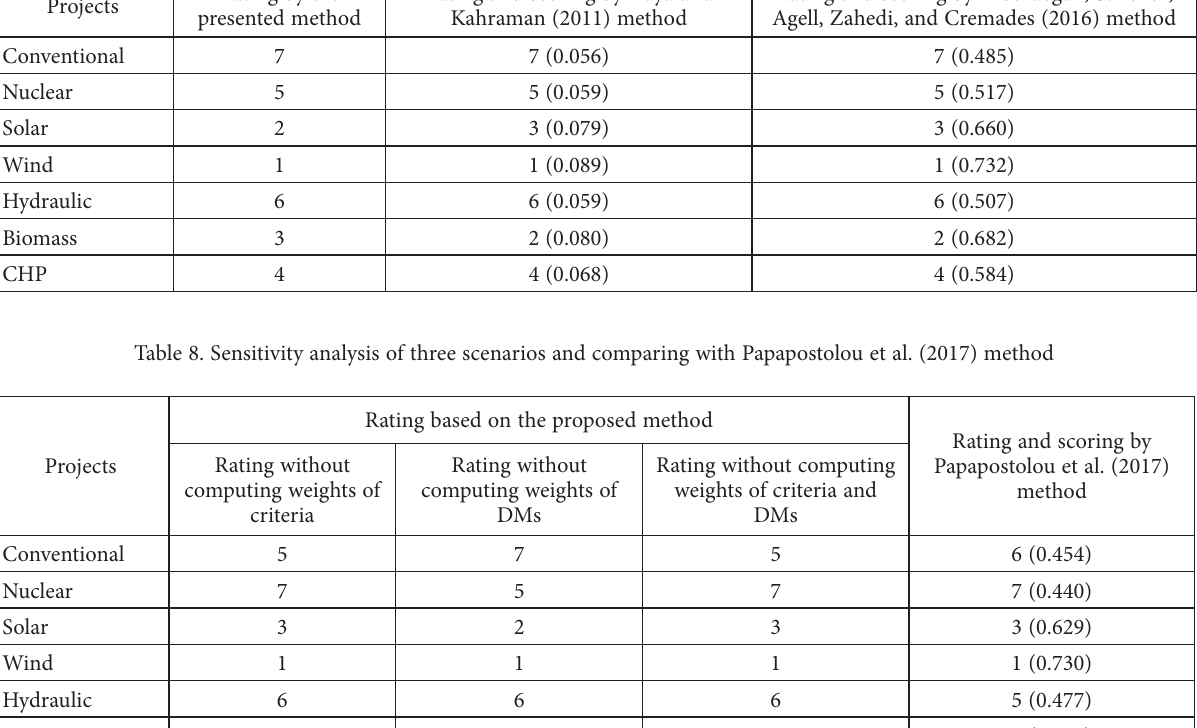
Table 7. Results of prioritization of projects and comparison of different methods Rating by the Rating and scoring by Kaya and Projects presented method Kahraman (2011) method Conventional